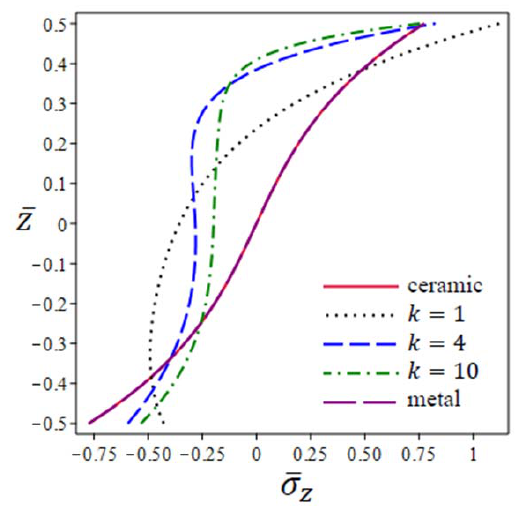
Figure 10: The transverse normal stress across the thickness of a FG